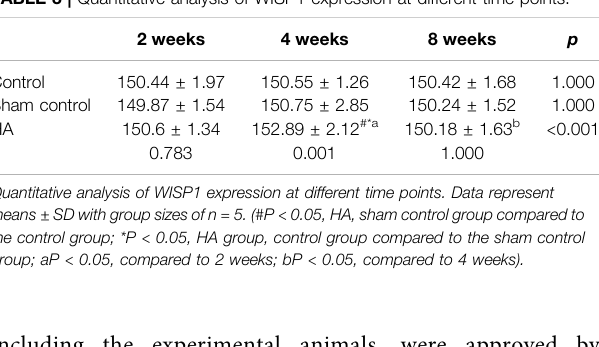
TABLE 3 | Quantitative analysis of WISP1 expression at different time